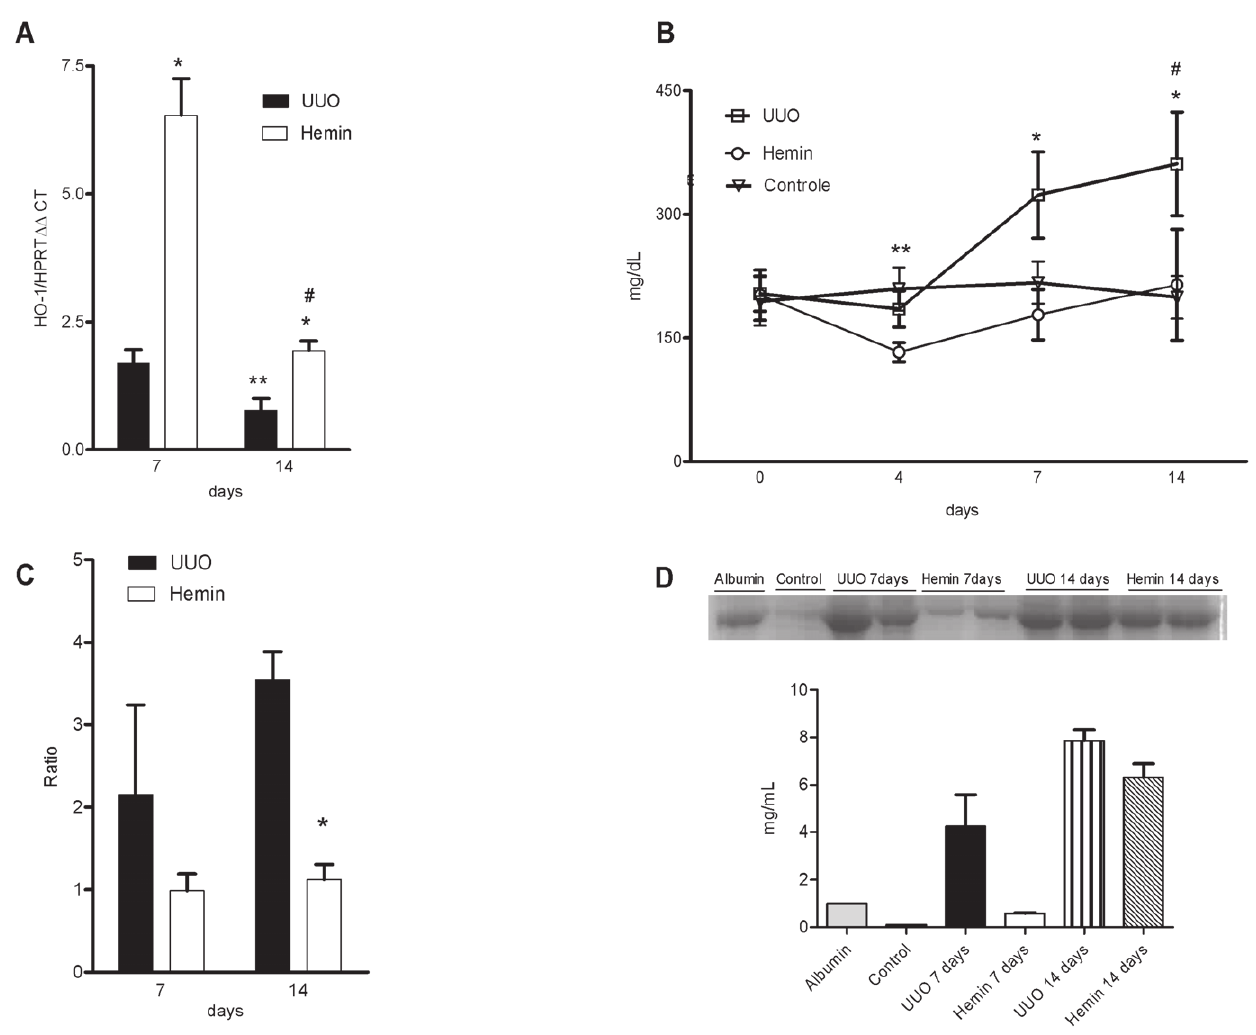
Figure 1. Treatment with Hemin upregulates HO-1 and leads to improved renal functional outcome. (A) Relative mRNA expressionofHO- 1 in obstructed kidneys from untreated (UUO) and treated (Hemin) animals,7 and14 days after surgery. mRNA values from samples are relatively expressed toControl animals, whichwereassigneda value of1.*p , 0,001vs. UUO,**p , 0,05vs.UUO7days and # p , 0,001vs. Hemin7days.(B)Urine proteinvalues (mg/dL) from bladder of control, UUO and Hemin-treated animals. *p , 0,05 vs. Hemin, # p , 0,05 vs. Control and **p , 0,05 vs. Hemin. (C) Urine protein/ creatinine ratio of obstructed pelvis collected by puncture at time of sacrifice from UUO and Hemin-treated animals. *p , 0,05 vs. UUO 14 days. (D) Urine albumin excretion analysis. The top panel represents an SDS-PAGE showing the molecular weight of albumin. The graph below expresses the digital optic quantification from the SDS-PAGE. All data are expressed as average 6 s.e.m.